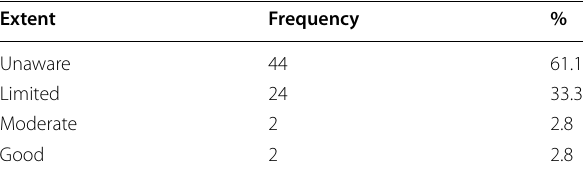
Table 6 Extent of first contact physiotherapy practice